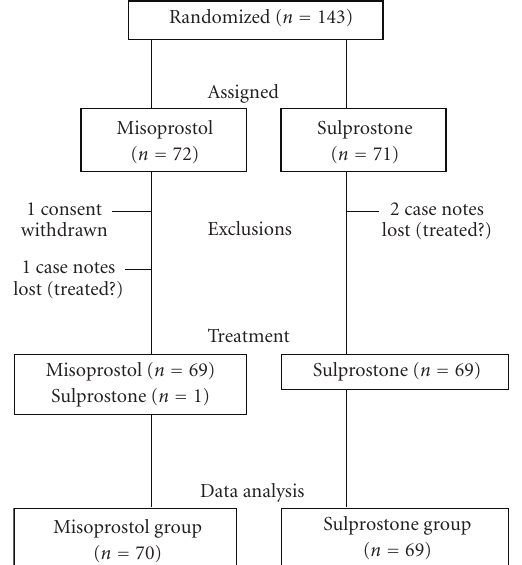
Figure 1: Flow diagram from randomization to analysis.